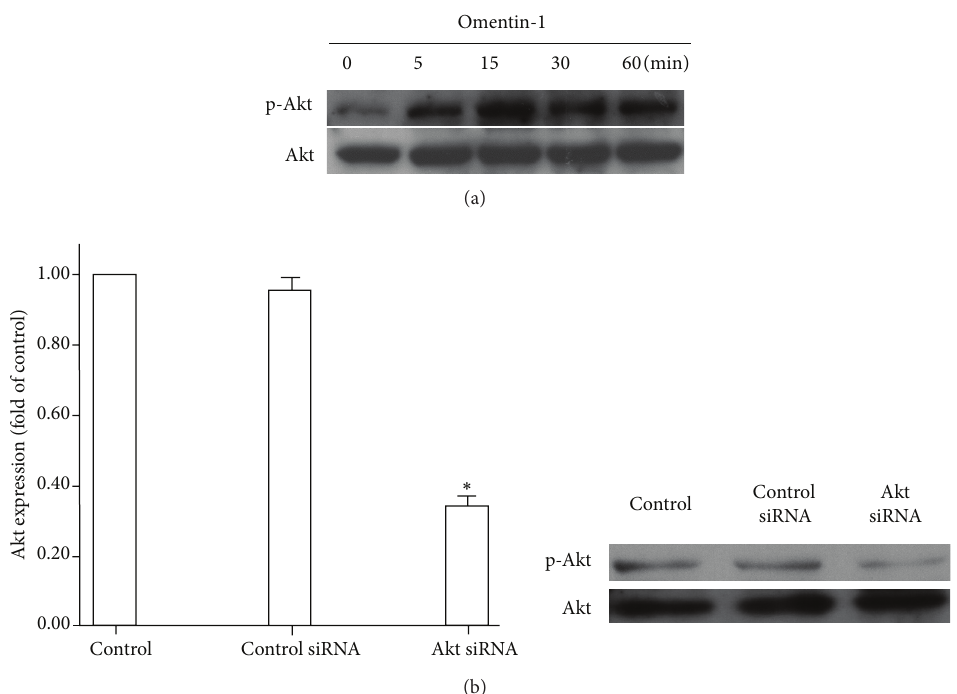
Figure2:Omentin-1activatedAktsignalpathwayinhOB.(a)WesternblotanalysisofAktactivation.ThehOBswereculturedinserum-freea- MEMfor6handthentreatedwithomentin-1(200ng/mL)for5–60min.Thecelllysateswereanalyzedbywesternblottingandincubatedwith antibodies against p-Akt and Akt. Representative results are shown. (b) Either control siRNA or Akt siRNA was transfected into osteoblast. Akt siRNA significantly suppressed the expression of phosphor-Akt (left). Expression of Akt was determined by western blot analysis using an Akt antibody. Representative results are shown